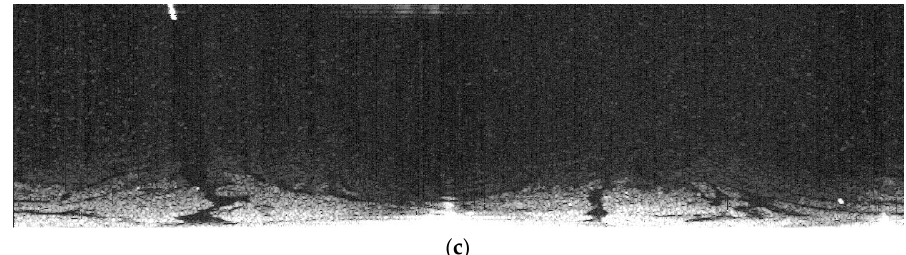
Figure 6. Radar image with small objects erased: ( a ) binarization of the radar image without co-channel interference; ( b ) extracted noise as bright speckles; and ( c ) processed radar image after noise reduction.